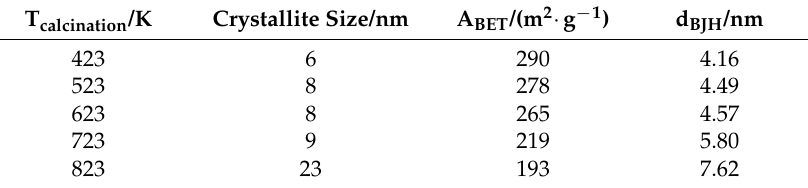
Figure 6. XRD patterns of ( a ) TiO 2 and ( b ) composite TZSG (50/50) from sol-gel synthesis after calcination at different temperatures. Table 3. Crystallite sizes of TiO 2 as well as specific surface area A BET and average pore width d BJH of the composite TZSG (50/50) from sol-gel synthesis after calcination at different